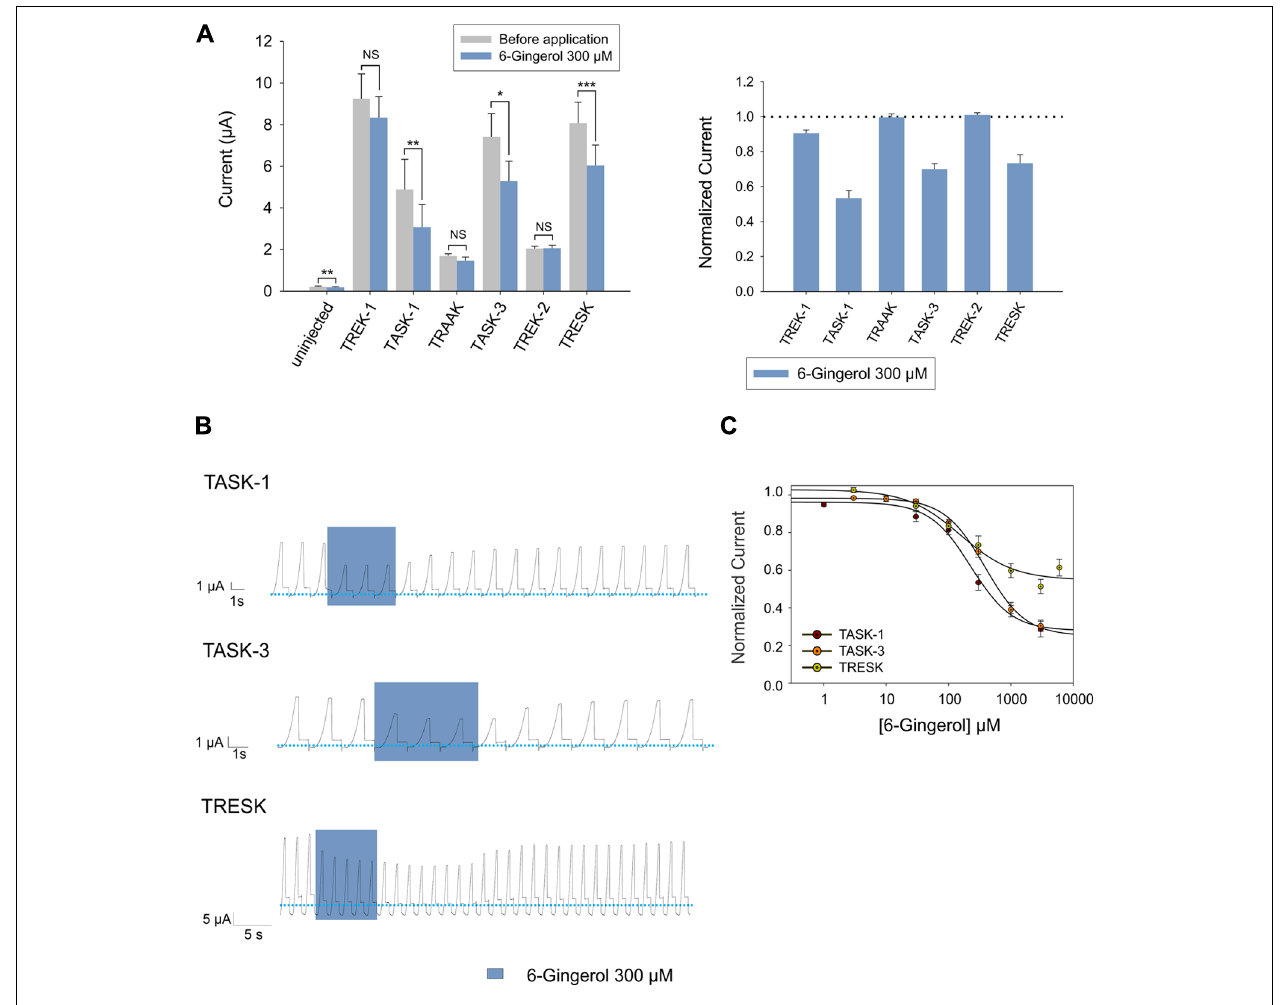
FIGURE 4 | (A) Left (from left to right) absolute currents presented by: uninjected Xenopus oocytes, oocytes injected with cRNA coding for hTREK-1, hTASK-1, hTRAAK, hTASK-3, hTREK-2 and hTRESK, before and after the application of 300 μ M 6-gingerol. Right normalized currents showing the effect of 300 μ M 6-gingerol on Xenopus oocytes injected with cRNA coding for hTREK-1, hTASK-1, hTRAAK, hTASK-3, hTREK-2 and hTRESK. For each group, the current was normalized to the current registered prior to the application of 300 μ M 6-gingerol (dotted line). All data are expressed as the